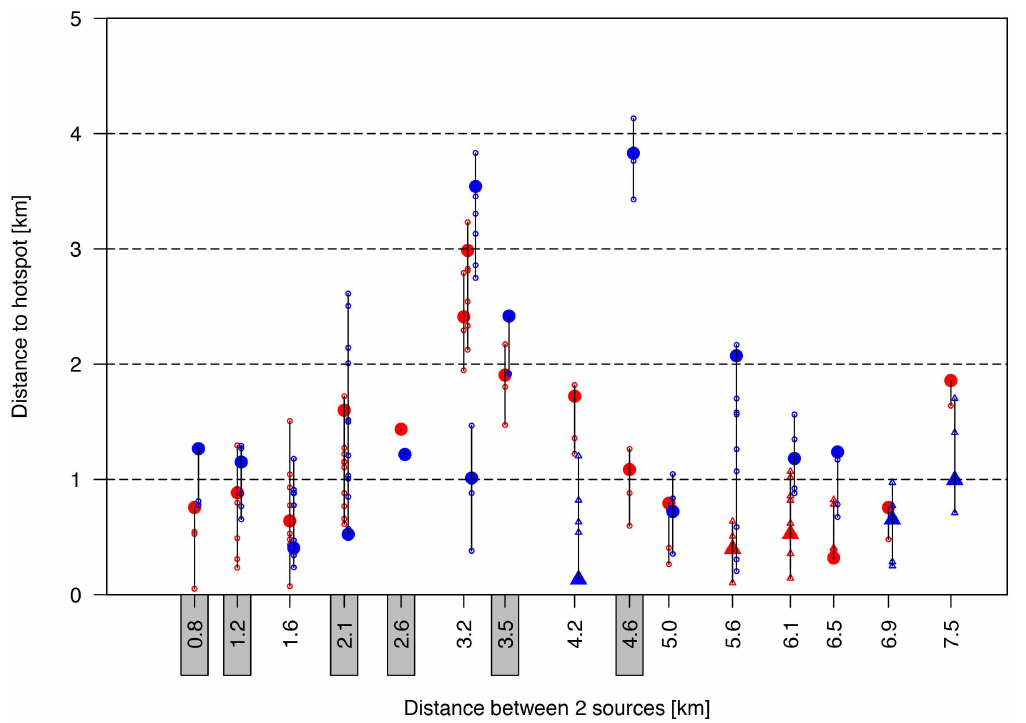
Figure 4. Two source simulations with the distance from the two sources to their closest hotspot as function of the distance between the two sources. The one source is indicated in red; the other in blue. The distance to all grid cells with nMR . 0.9 is listed by small open circles; the grid cell with the maximum nMR-value in the hotspot is indicated by a large closed circle. If a local maximum with nMR-values , 0.9 appeared, then triangle symbols are used, taking into account all grid cells with nMR-values of 0.10 lower than the local maximum. If a source could not be attributed to a single hotspot, then the distance to both hotspots was indicated (e.g., at x=3.2 km). Results with just one hotspot are indicated by the grey rectangles at the x-axis.